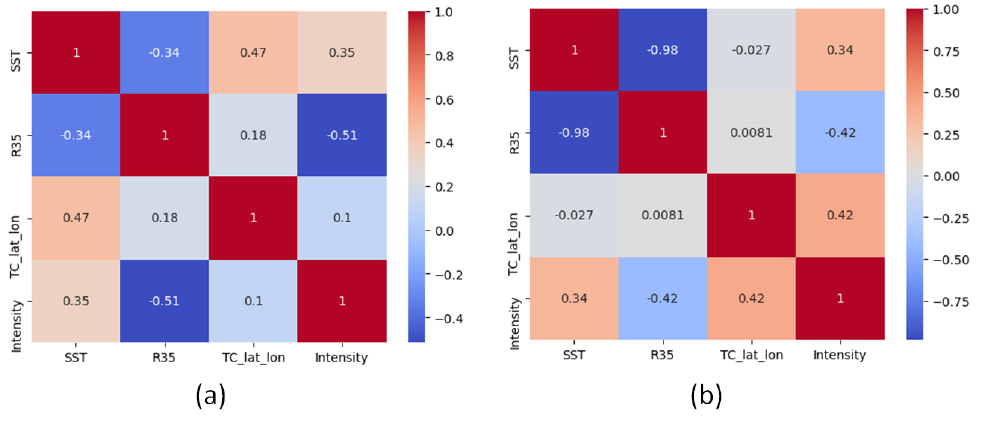
Figure 6. Correlation matrix of environmental factors and TC intensity values in ( a ) 2015 and ( b ) 2017. Each cell in the matrix represents the correlation coefficient between two variables, and the color of the cell indicates the magnitude of the correlation coefficient. The diagonal cells represent the correlation coefficient between the variable and itself, which is always